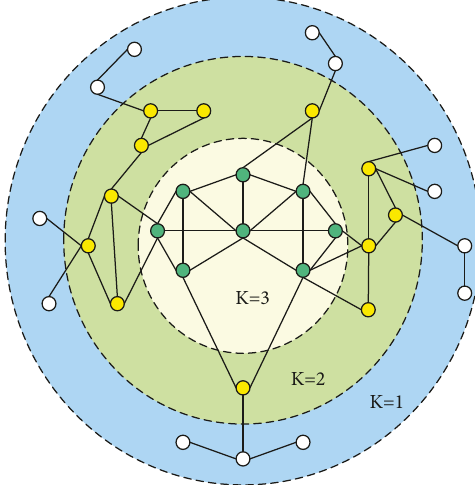
Figure 3: Steps to acquire the k -core value of the nodes in the